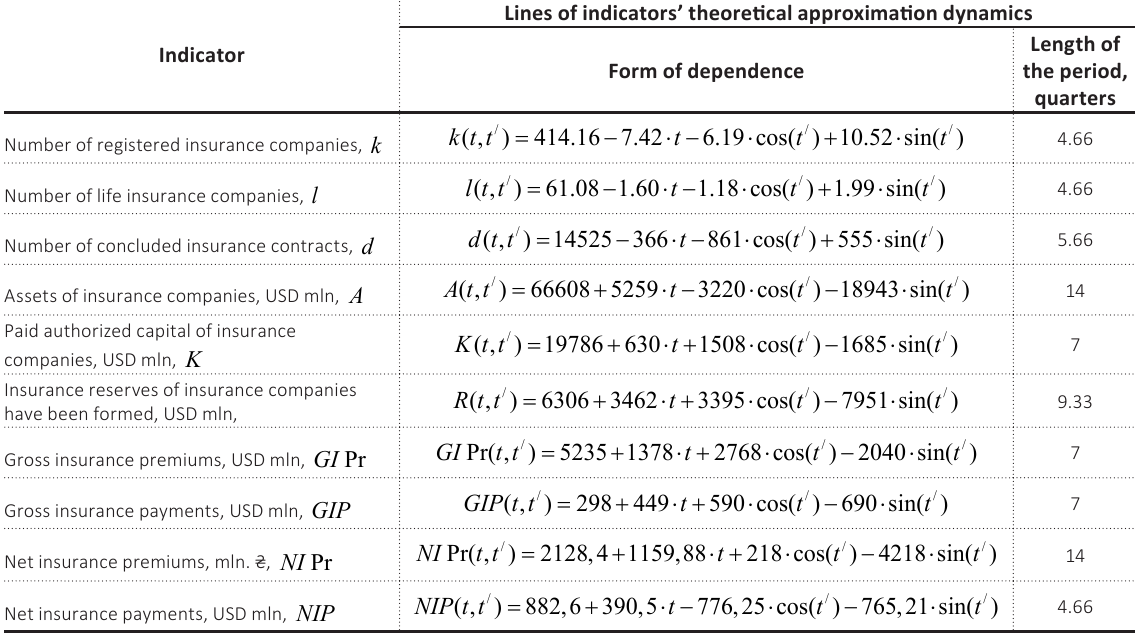
Table 1. Description of lines of theoretical approximation dynamics of indicators for Ukraine’s insurance